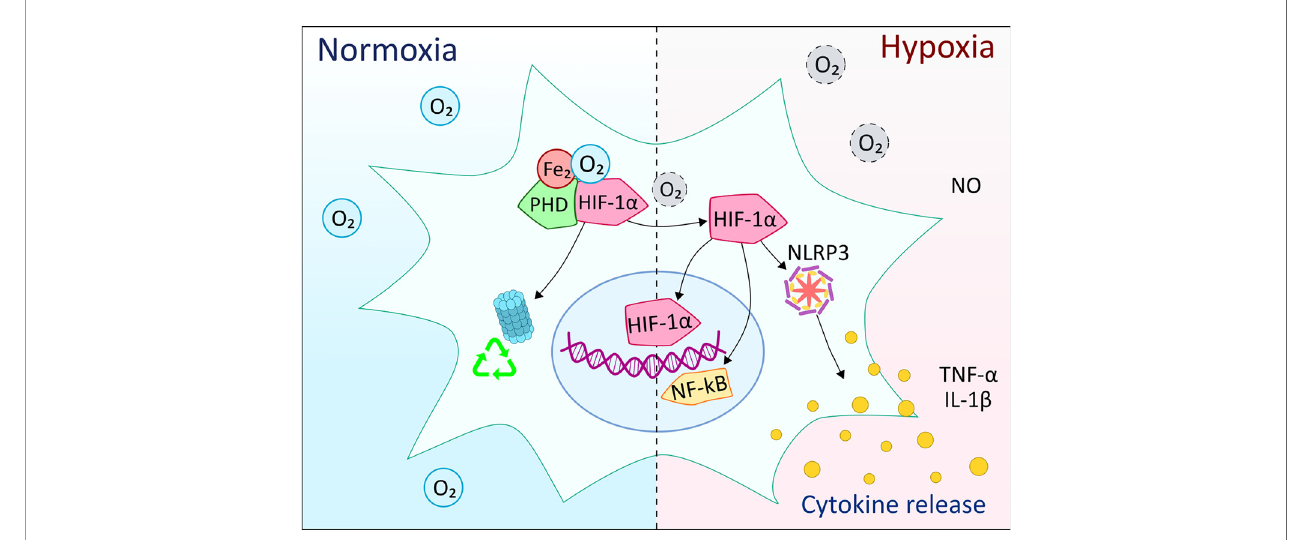
FIGURE 5 | Overview of the effects of hypoxia on microglia cells compared to normal oxygen levels. HIF-1 a is one of the main components of the response to hypoxia in myeloid cells. Under normoxic conditions, the oxygen molecules participate in the HIF-1 a hydroxylation, ubiquitination and subsequent degradation by the proteasome complex. In hypoxia, the lack of oxygen molecules prevents ubiquitination and degradation of HIF-1 a , which can then translocate to the nucleus and, together with other co-activating elements, initiate the expression of pro-in fl ammatory molecules. At the same time, HIF-1 a activation might involve crosstalk with NF- k B, NLRP3 in fl ammasome, as well as nitric oxide (NO) production along with pro-in fl ammatory